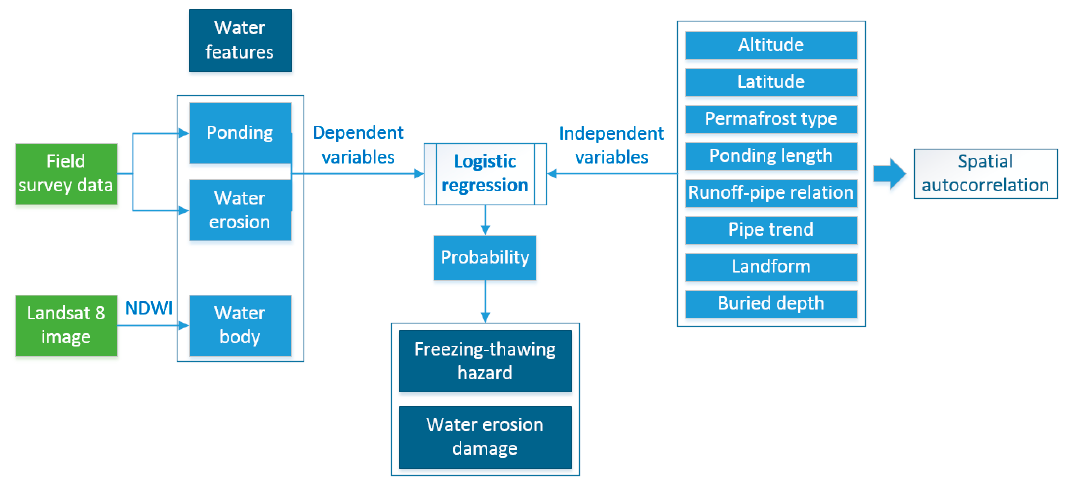
Figure 3. Flowchart of the acquisition of water features and the calculation of hazard probabilities along the China–Russia crude oil pipeline (CRCOP) route.